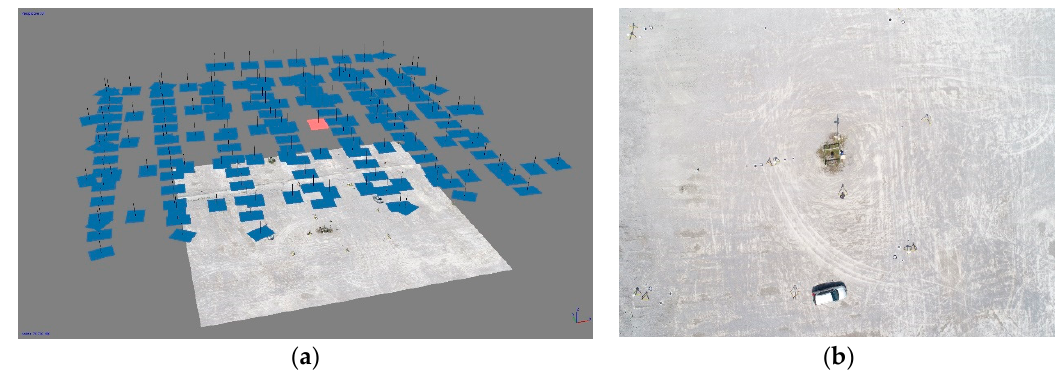
Figure 11. Photogrammetric survey: ( a ) Photogrammetric block UAV40 (oriented images and dense point cloud); ( b ) image sample (colored in red in (a)). Table 2. Characteristics of the photogrammetric blocks. GSD: Ground sample distance. Block Flight Altitude (m)